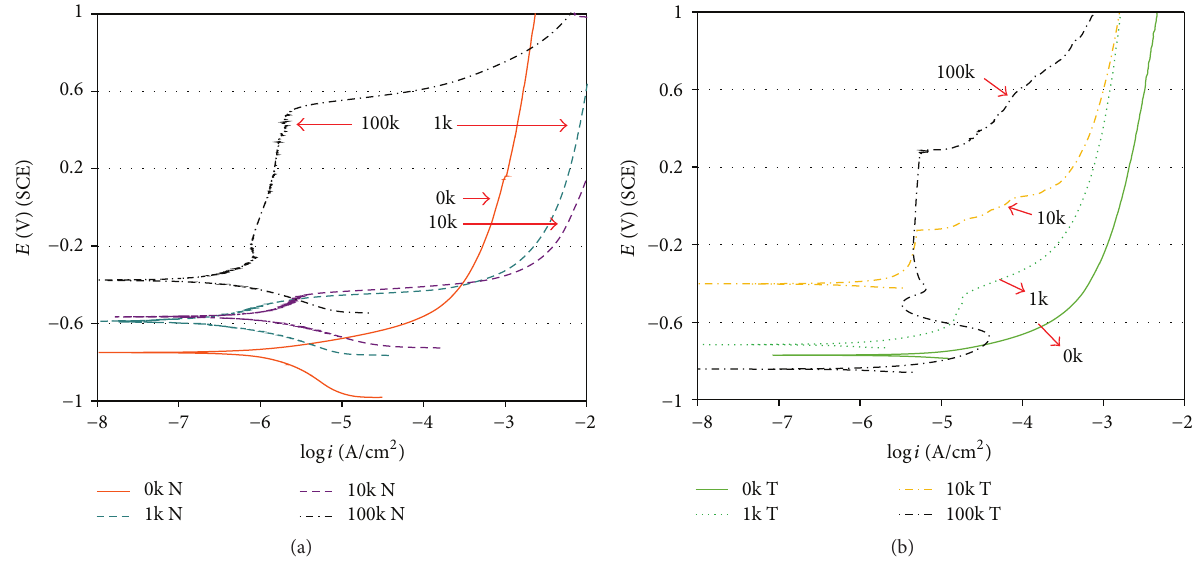
Figure 2: Effect of singly added corrosion inhibitors on anodic polarization curve of DCI (25 ∘ C deaerated tap water + x ppm corrosion inhibitor (N: NO 2− , T: TEA)); (a) nitrite addition, (b) TEA addition.